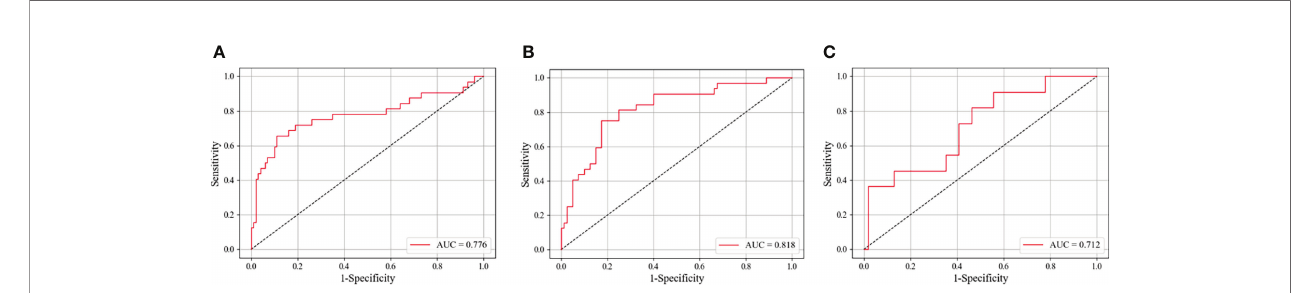
FIGURE 3 | The ROC curves of our DCNN model in identifying different breast cancer molecular subtypes on the test set. (A) Classifying luminal A from non-luminal A subtypes among patients older than 50 years. (B) Classifying luminal A from non-luminal A subtypes for tumor sizes ≤ 20 mm. (C) Classifying triple-negative from non-triple-negative subtypes for patients younger than 50 years. ROC, receiver operating characteristic; AUC, area under the ROC curve; DCNN, deep convolutional neural network.